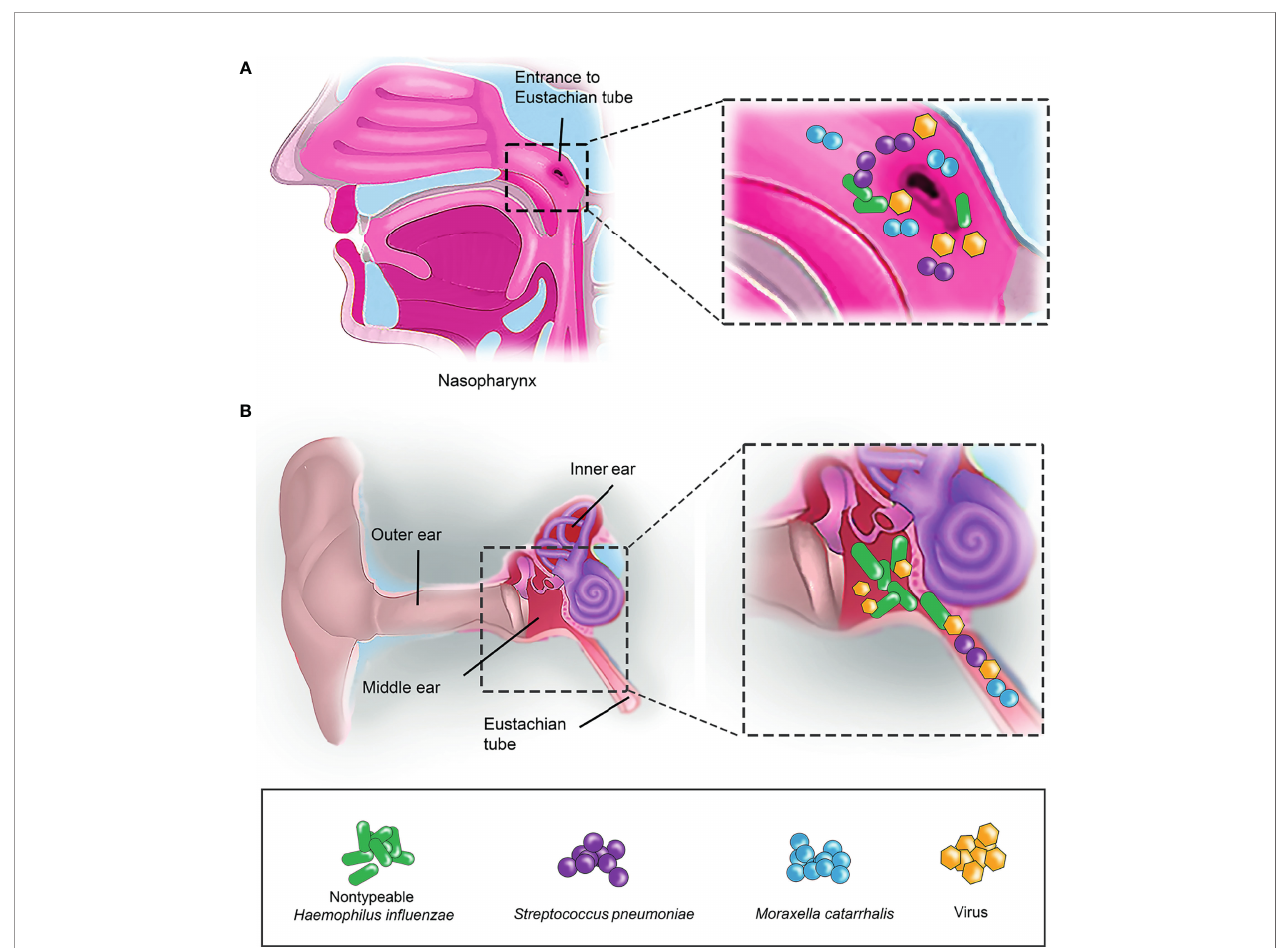
FIGURE 1 | Bacterial colonisation in human nasopharynx and middle ear. (A) Nasopharynx is the primary entrance for airway pathogens. Small insert (left panel) indicates the enlarged view of the entrance to Eustachian tube in nasopharynx. Airway pathogens such as nontypeable H . in fl uenzae (NTHi) (indicated as green rod) , S. pneumoniae (Spn) (purple sphere) and M. catarrhalis (Mcat) (blue sphere) that initially colonize the nasopharynx as part of the commensal microbiota can, however, migrate into the middle ear (ME) via the Eustachian tube. (B) Co-infection of airway pathogens and viruses in the ME. Airway pathogens (NTHi, Spn